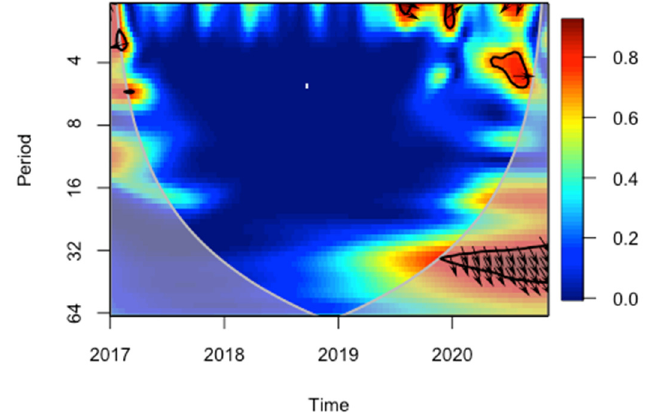
Panel A . Wavelet coherence: NFT attention and Bitcoin returns